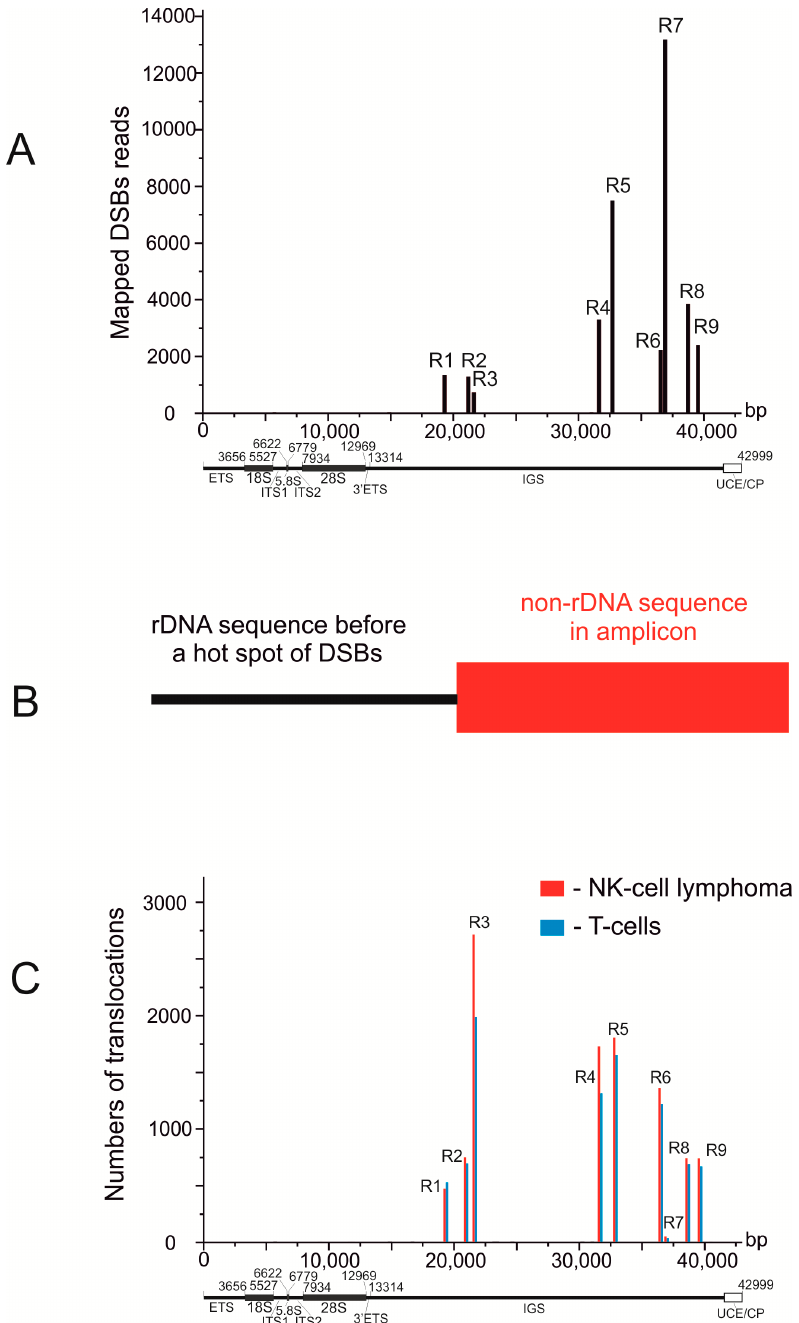
Figure 1. Hot spots of DSBs coincide with translocation sites in rDNA units. ( A ) mapping of DBSs along rDNA genes in HEK293T cells [21] R1–R9 are the hot spots of DSBs or Pleaides. UCE/CP: upstream promoter element and core promoter. ( B ) the scheme illustrates the search for rDNA- mediated translocations in WGS amplicons after paired-end sequencing. Amplicons possessing rDNA sequences located before Pleaides at one end and non-rDNA sequences at the other end were selected for further analysis. ( C ) mapping of the detected translocations along rDNA units in T cells and in NK-cell lymphomas. The 102 samples correspond to normal T cells and NK-cell lymphomas from the same